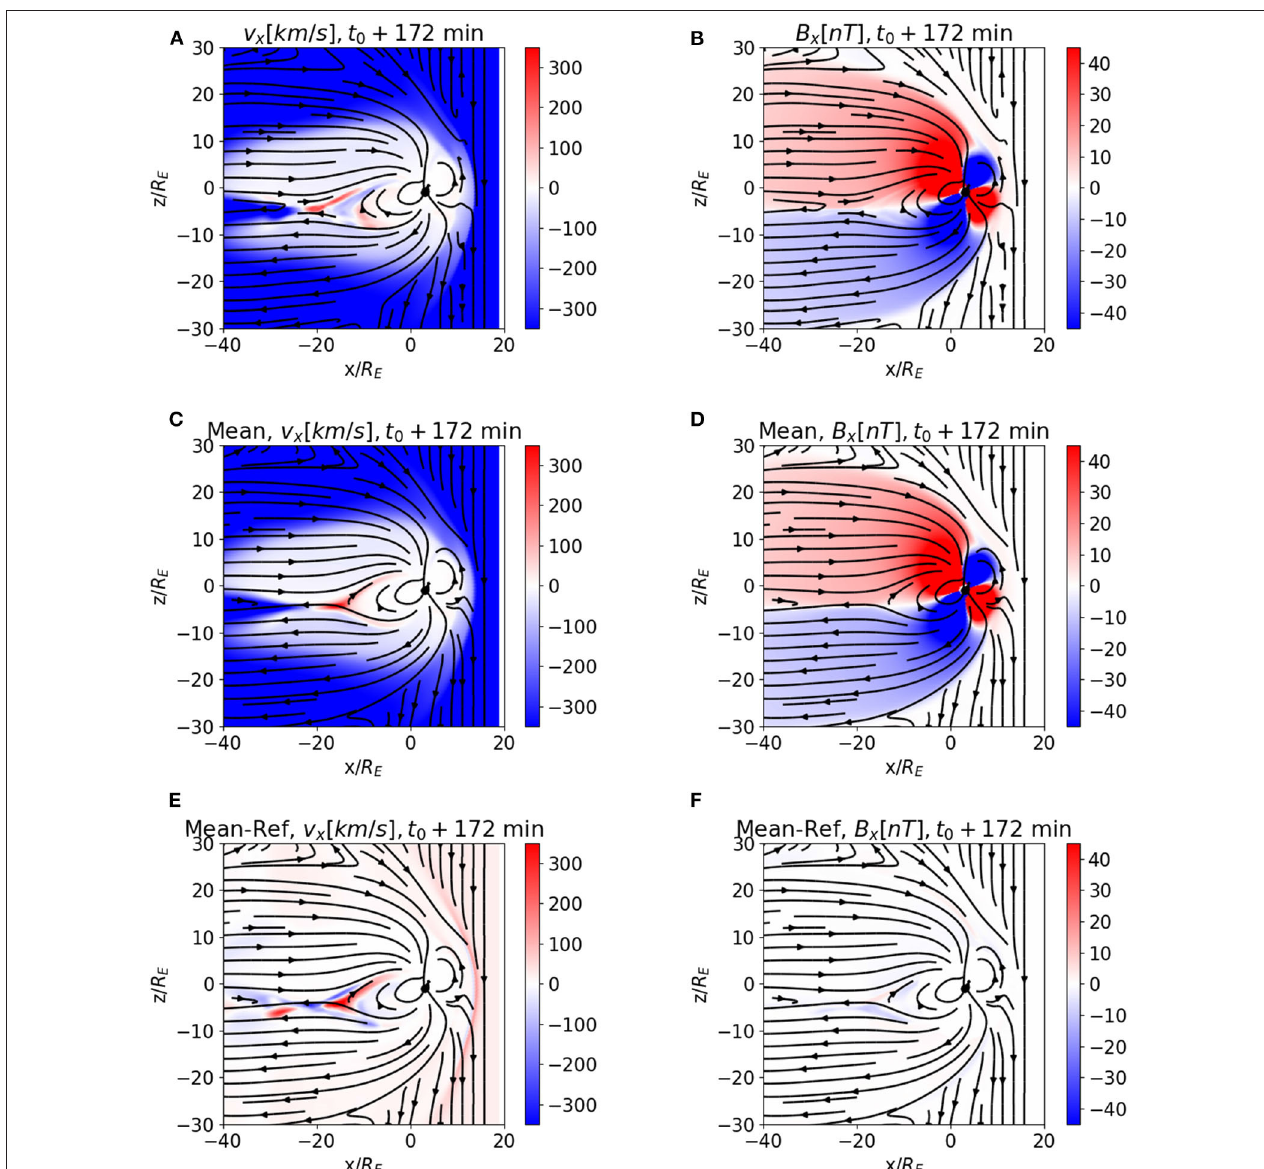
FIGURE 1 | Reference simulation (A,B) , ensemble mean (C,D) , and difference between the ensemble mean and the reference simulation results (E,F) for the ensemble of OpenGGCM magnetospheric simulations. The ensemble is generated by perturbing the v x solar wind boundary condition. v x is depicted in (A,C,E) , b x in (B,D,F) . The coordinate system is GSE The depicted time is 172 min after the beginning of the simulation, May 8th 2004, 9:00 UTC. The boundary conditions at the sunward boundary of the “reference” simulation are observed solar wind values.